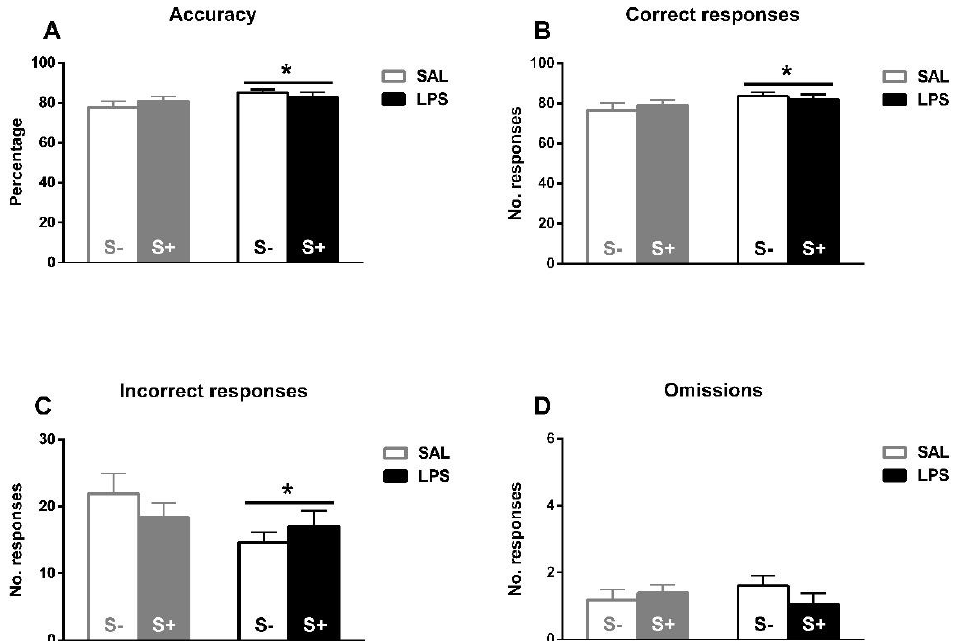
Figure 4. 5-CSRT task baseline performance in saline-control (SAL/S-), LPS-control (LPS/S-), saline- stress (SAL/S+), or LPS-stress (LPS/S+) groups ( n = 12). ( A ) Mean accuracy. ( B ) Mean correct responses. ( C ) Mean incorrect responses. ( D ) Baseline mean omissions. Asterisks represent LPS effect: exposed animals a better overall performance in terms of higher accuracy, more correct responses, and less incorrect responses. Data are represented as mean ± SEM.